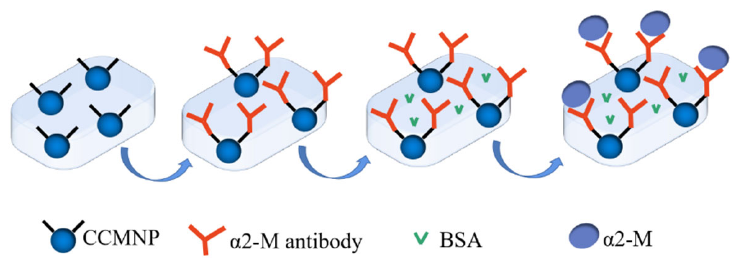
Figure 3. Modification process of α 2 ‐ M antibody on the biosensor.